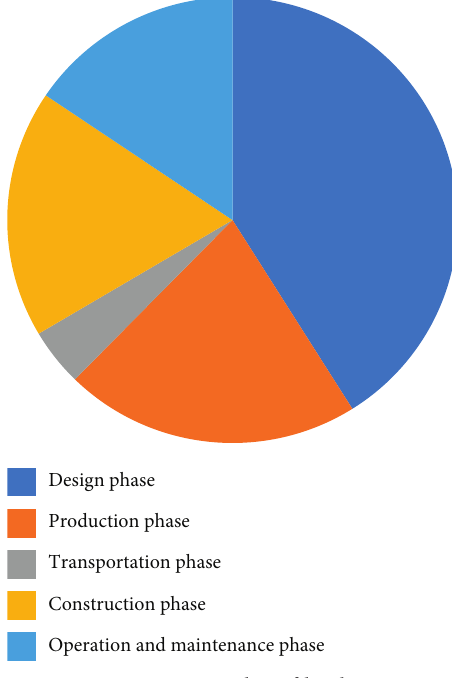
Figure 1: Weights of level